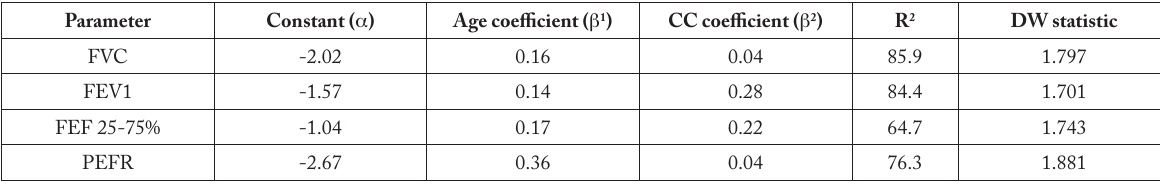
Table 2. Prediction equations for spirometry parameters.